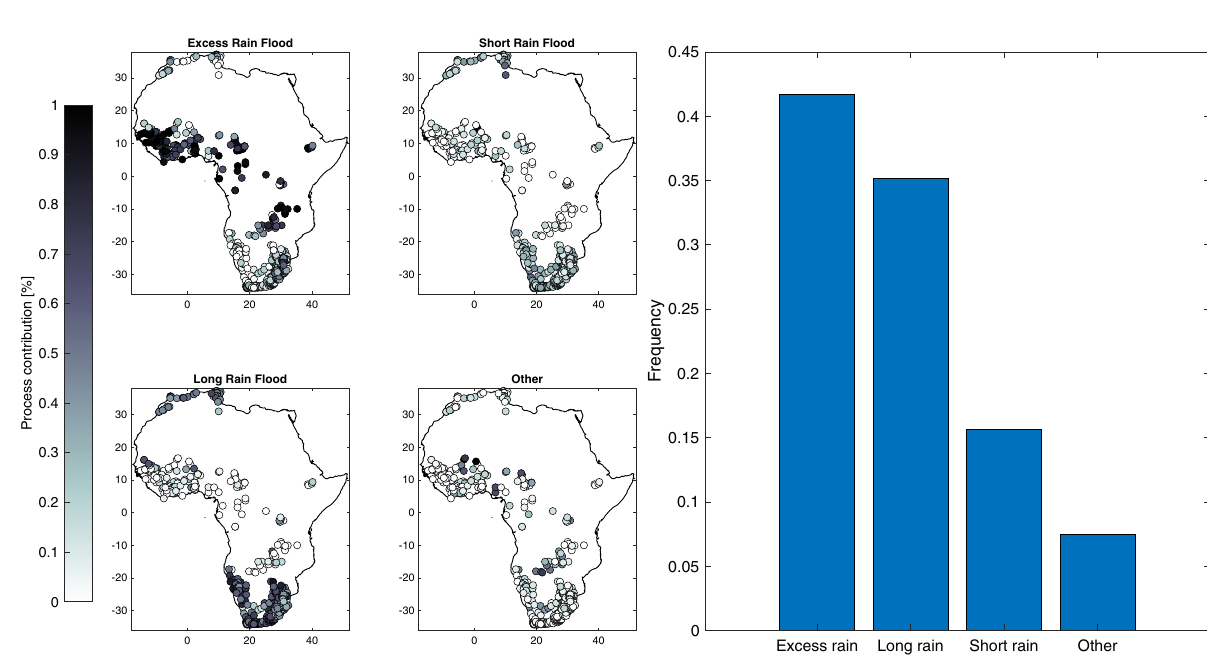
Figure 3. Results of the flood event driver’s classification. The left panels are showing the relative contribution of the different flood-generating process for each basin, the histogram on the right shows the relative importance of each flood generating processes for all